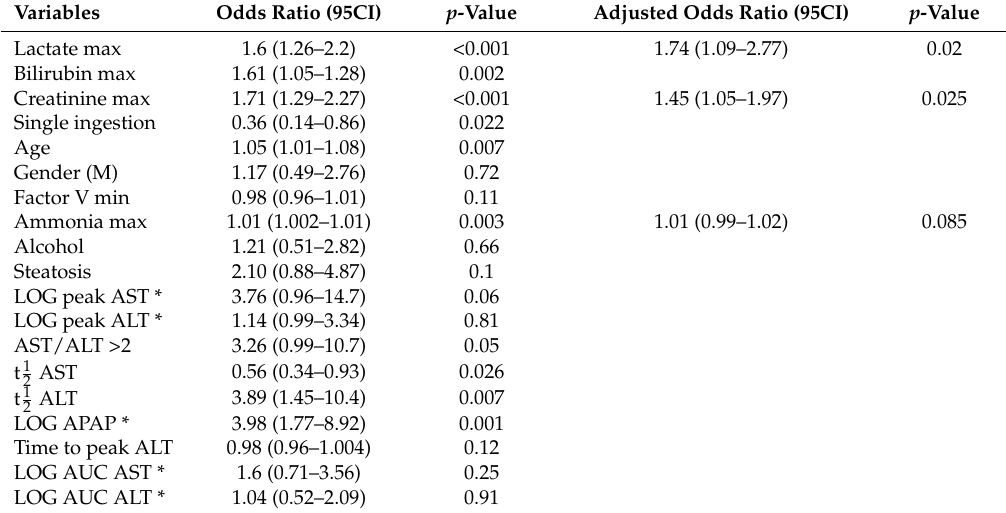
Table 4. Univariate and multivariate analysis to predict bad outcome. * Values were log-transformed. Legend: AUC, area under the